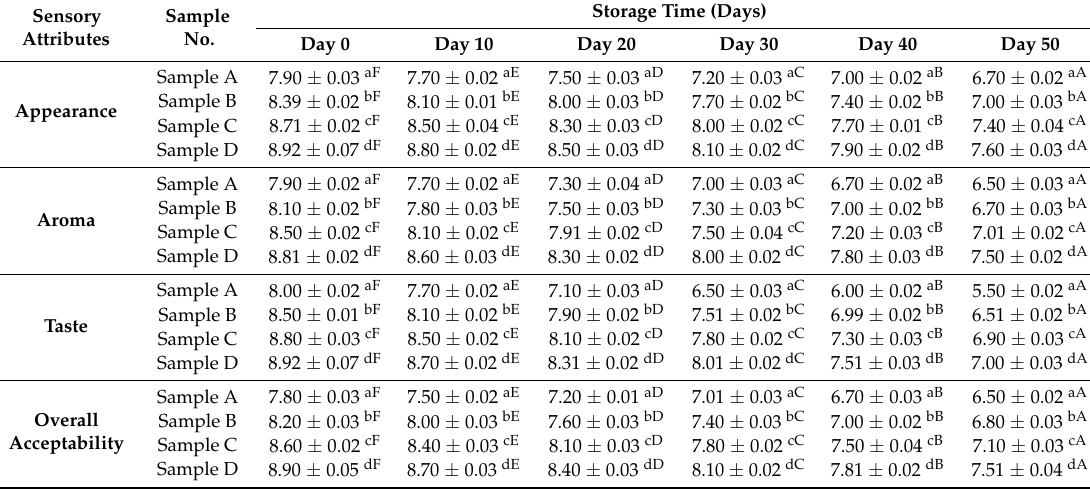
Table 3. Sensory evaluation of samples over the storage